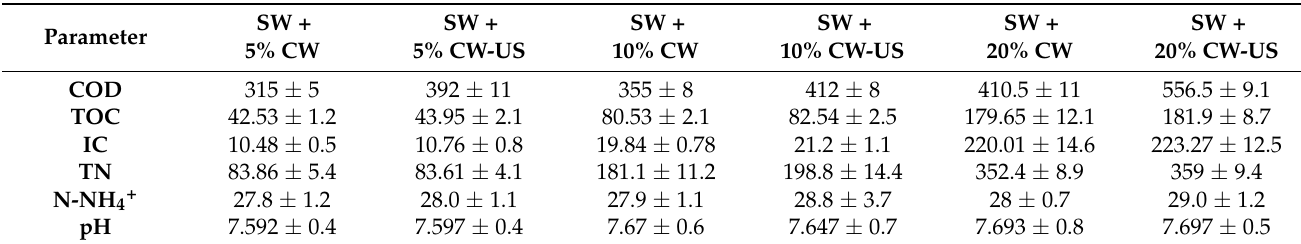
Table 6. Characteristics of used test mixtures—synthetic wastewater (SW) with an addition of coke wastewater (CW) (5%, 10%, 20%) and ultrasound